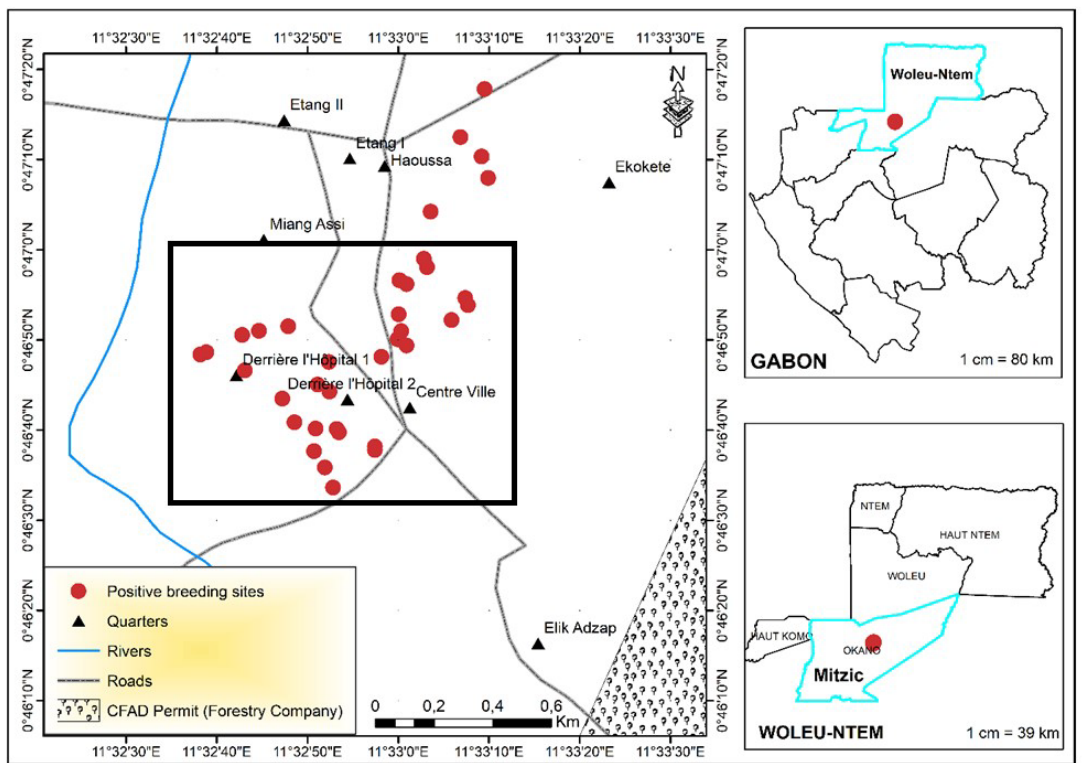
Figure 5. Map showing the positive breeding sites (red dots) of Anophelinae and quarter where patients originate (black triangle) in Mitzic. The quarters inside the black rectangular area belong to the urban area or town, and those outside are quarters of the surrounding villages or rural areas